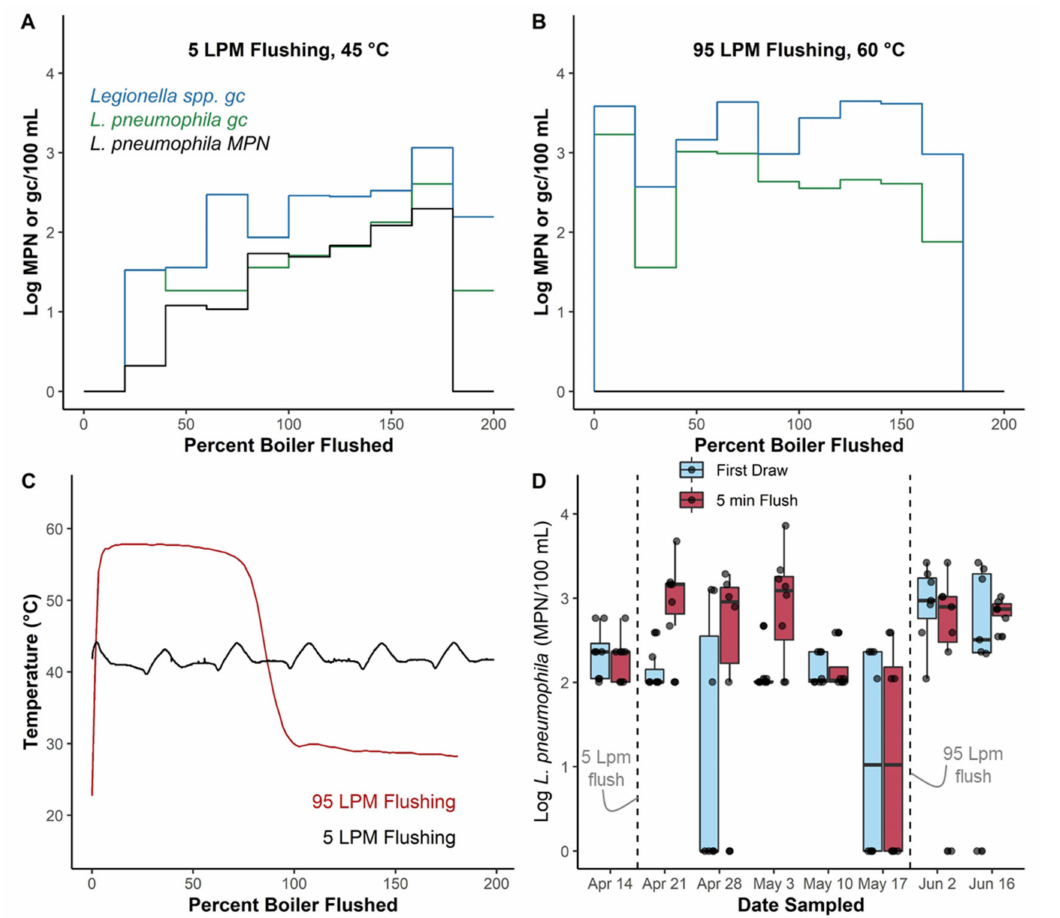
Figure 5. L. pneumophila culture and Legionella spp. and L. pneumophila gene copy numbers as a function of boiler volume flushed ( A ) at one outlet at 5 Lpm or ( B ) at 95 Lpm; ( C ) water temperature profiles during flushing; ( D ) L. pneumophila culture numbers in 8 first draw and 8 5-min flushed samples collected from the same outlets before and after flushing at 5 and 95 Lpm. Boxplot bodies reflect the 25th, 50th, and 75th percentile; whiskers represent 1.5 times the interquartile range. Raw data is overlaid onto the